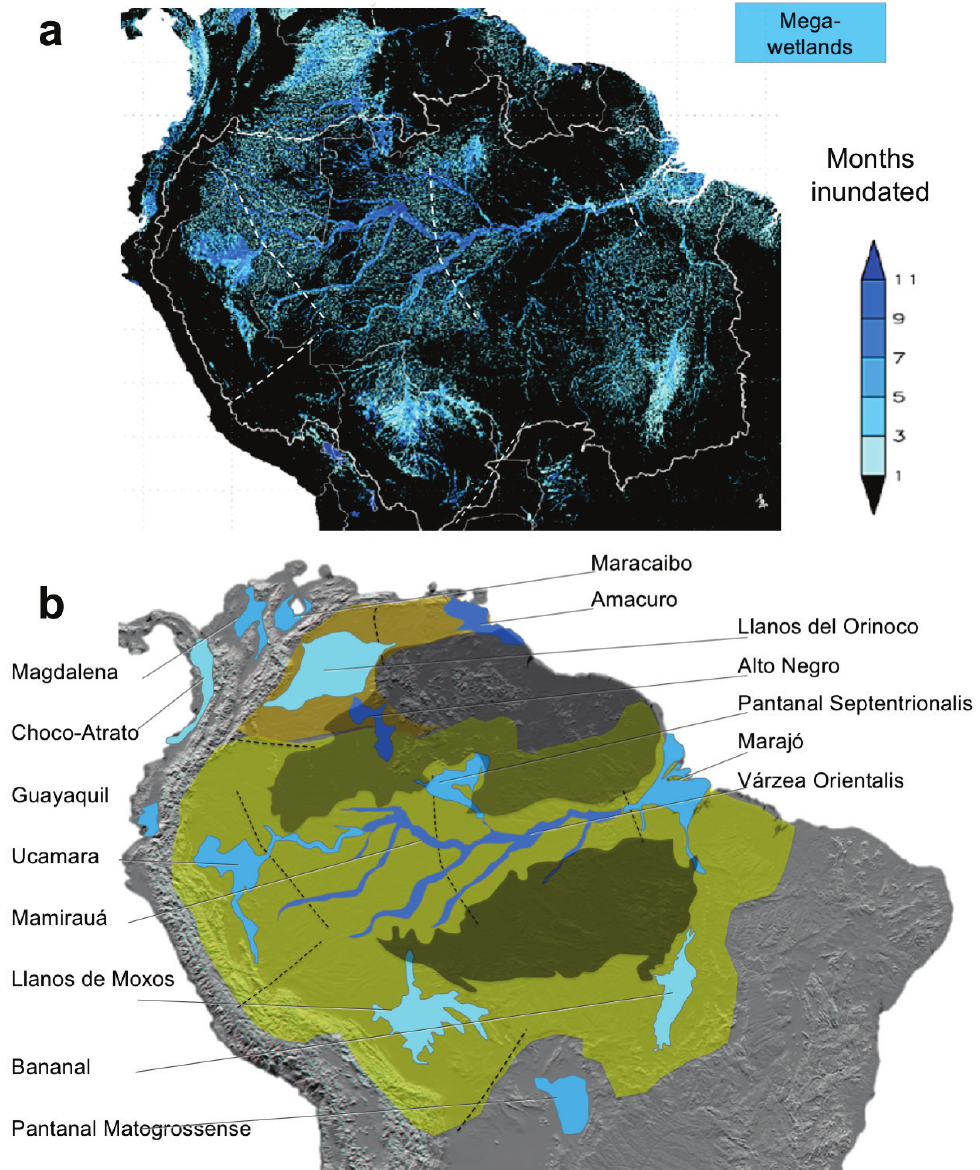
Fig. 6. Mega-wetland systems of modern tropical South America. a. Mean number of months of inundation (from Migue- z-Macho, Fan, 2012). Simulated flooding frequency as number of months per year over the 10-year period, 2001-2010. b. Schematic depiction of 15 largest mega-wetlands (>10,000 km 2 ); intensity of blue shading proportional to average annual duration of inundation. Cartographic conventions as in Fig. 3. Note highly fragmented distribution of mega-wetlands on the modern landscape, and localization of mega-wetlands towards center of larger sedimentary